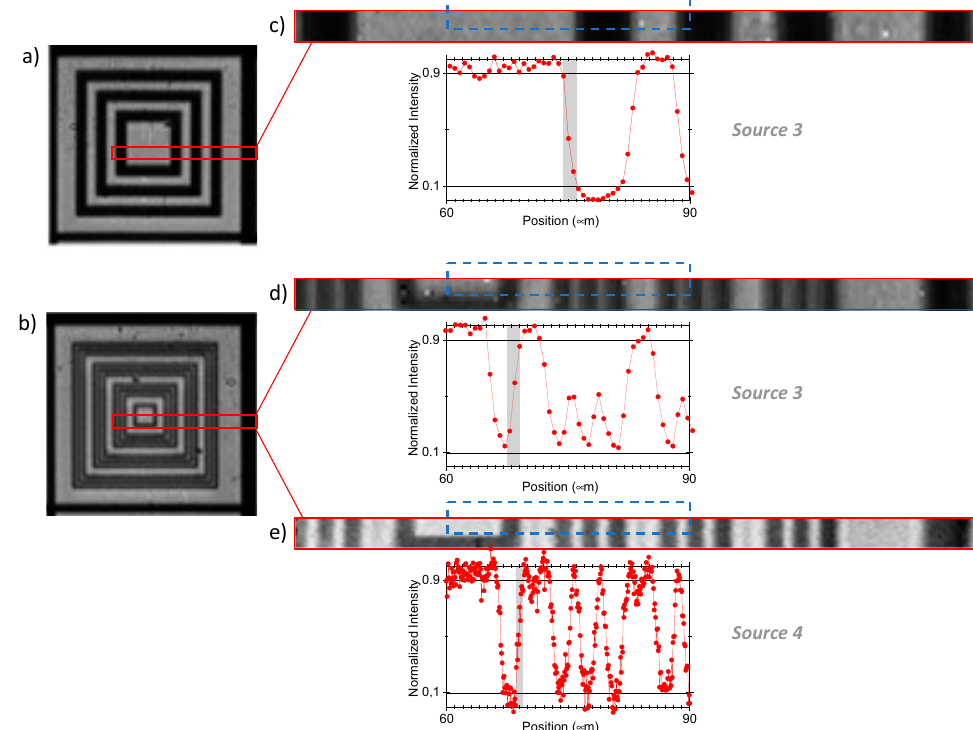
Figure 6. Static e-STOM images of aluminum-on-glass squares. In ( a ) the bars/spacings are 6.4 µ m/6.4 µ m thick, and in ( b ) they are 1.6 µ m/1.6 µ m grouped three by three, both imaged with source 3 . In ( c , d ), the respective central strips appear enlarged. In ( e ), the same area of ( d ) is imaged using source 4 . Below each strip, the normalized intensity profile of the area in the dotted rectangle is plotted, where major (black/white) contrast between the thickest features—used to obtain the ESF— is marked in grey.